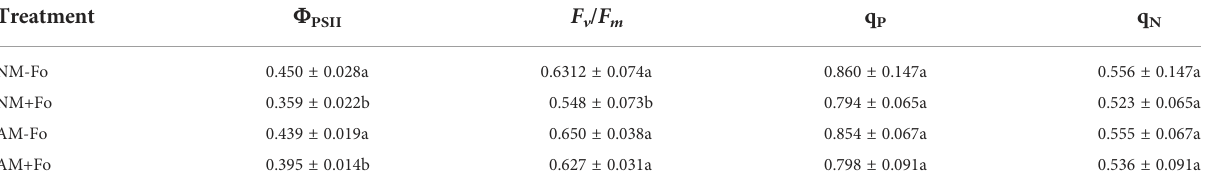
Values are means ± SD from four sets of independent experiments with 15 plants. Different lowercase letters indicate signi fi cant differences between different treatments according to two- way ANOVA followed by Tukey ’ s test for multiple comparisons (P <